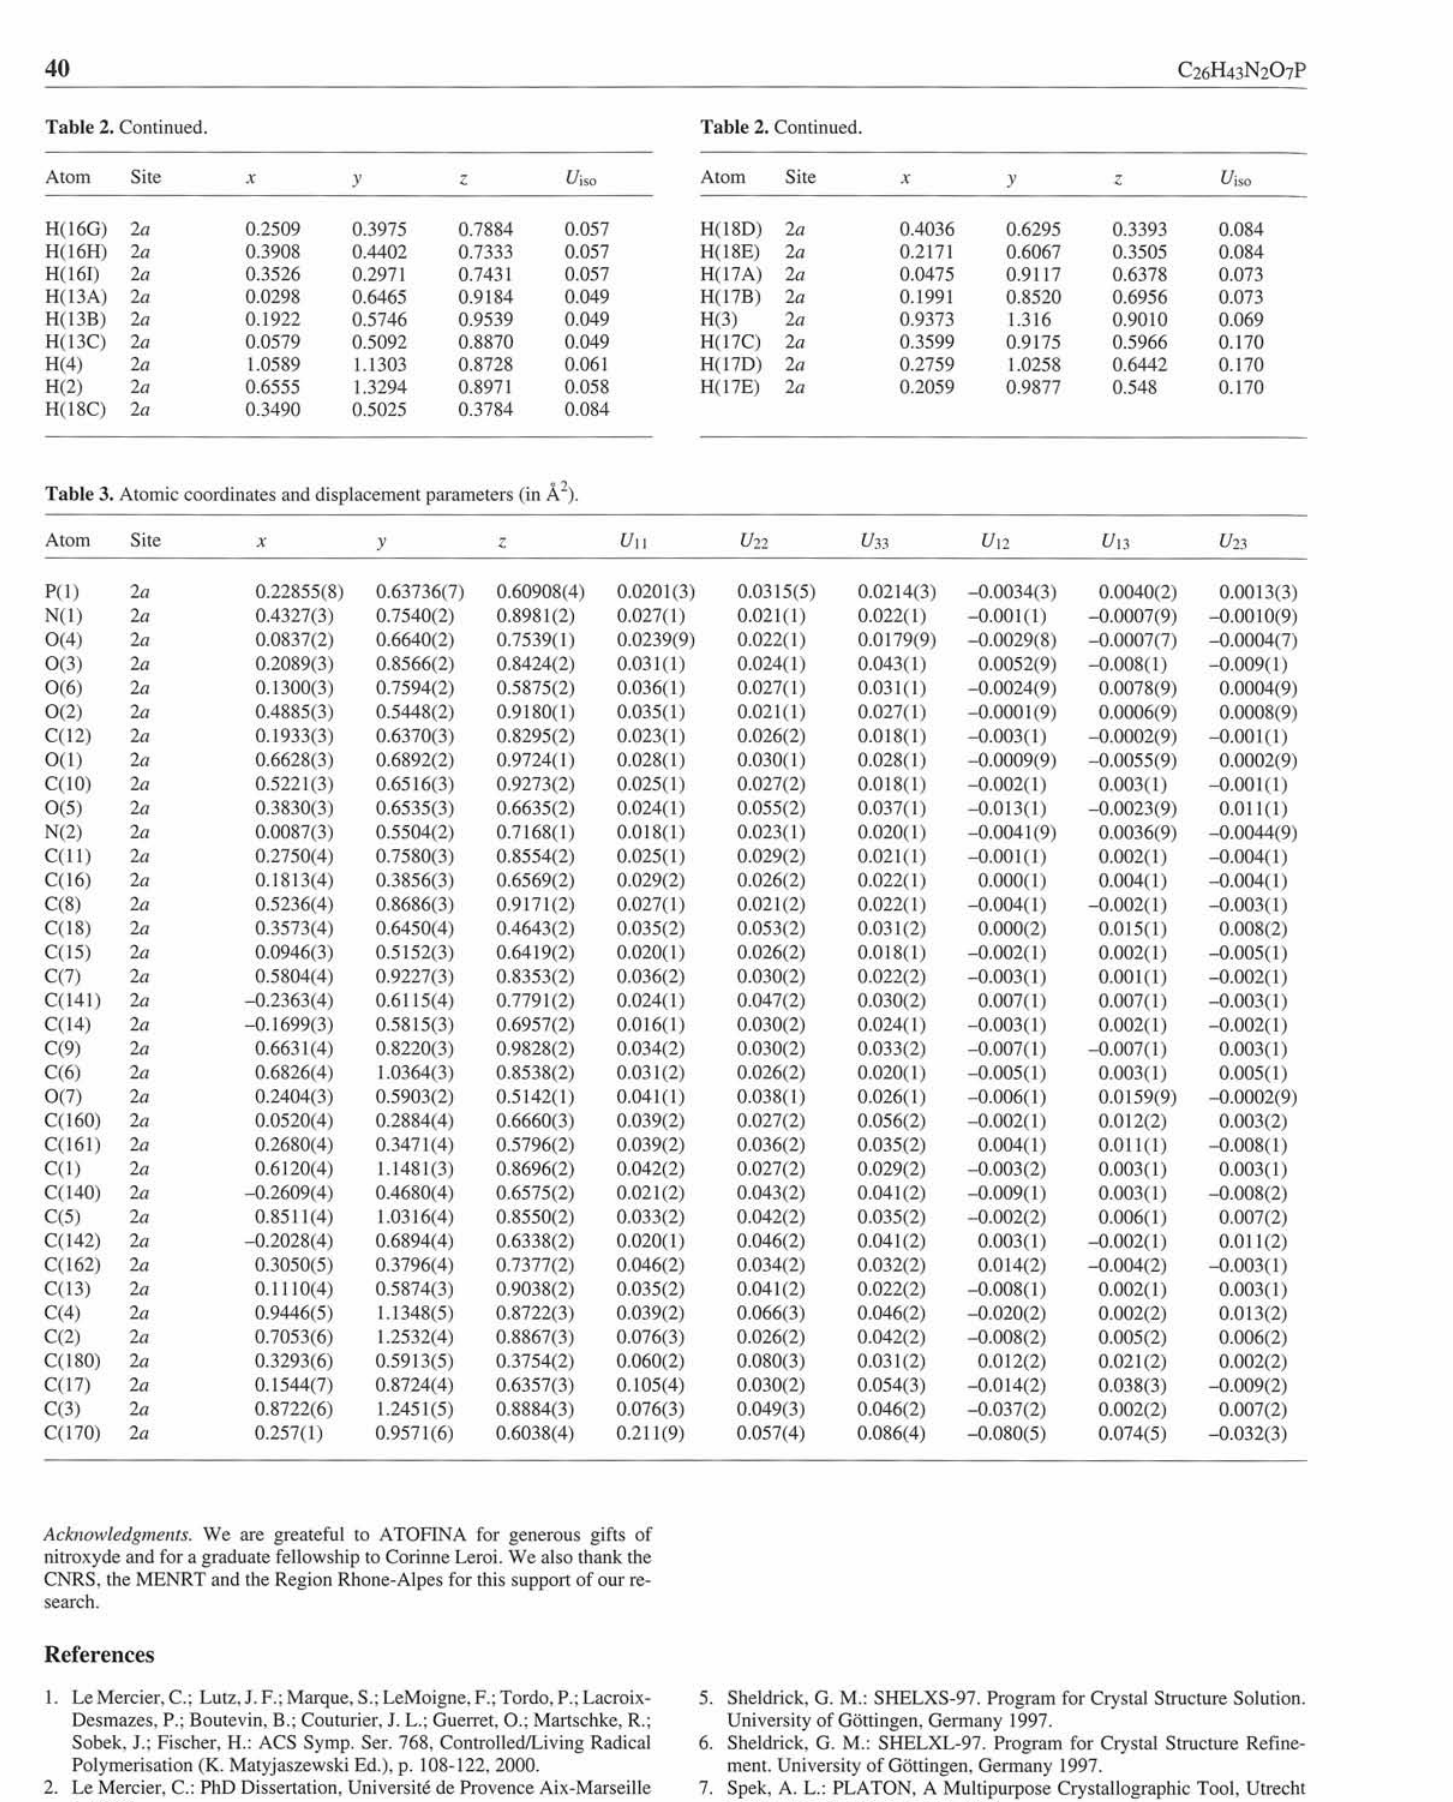
Table 3. Atomic coordinates and displacement parameters (in À 2